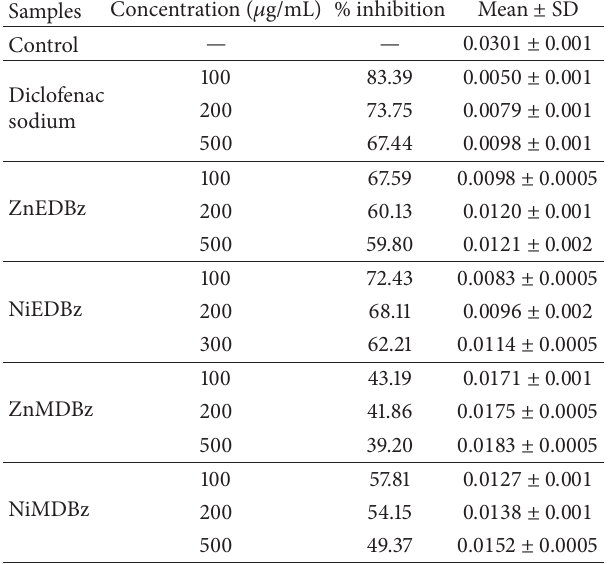
Table 4: Antidenaturation (anti-inflammatory activities) results.